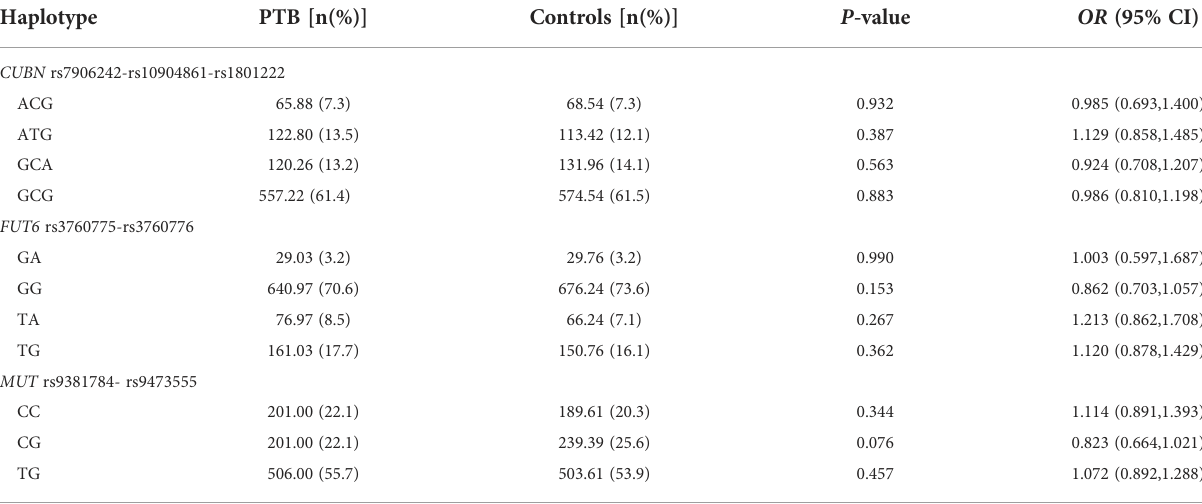
TABLE 3 Haplotype analysis of CUBN , FUT6 , and MUT genes in PTB patients and controls.